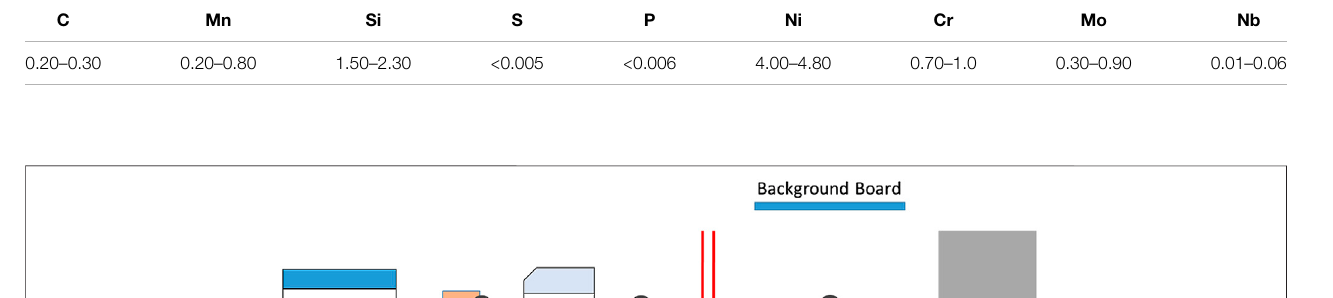
Table 1 . The experiment arrangement for the present tests is